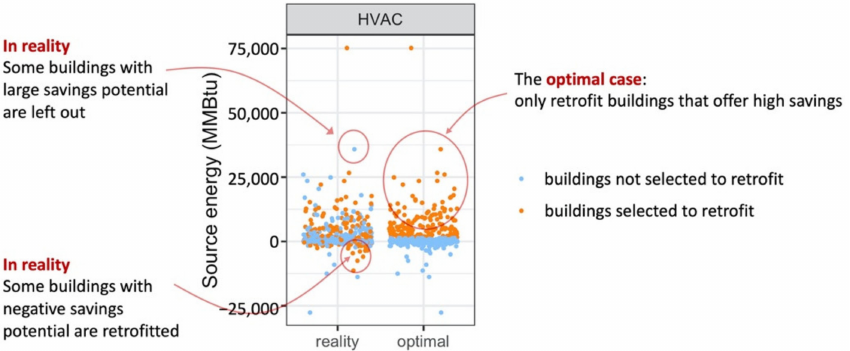
Figure 11. Illustration of why targeting works in improving portfolio-wide source energy savings of HVAC